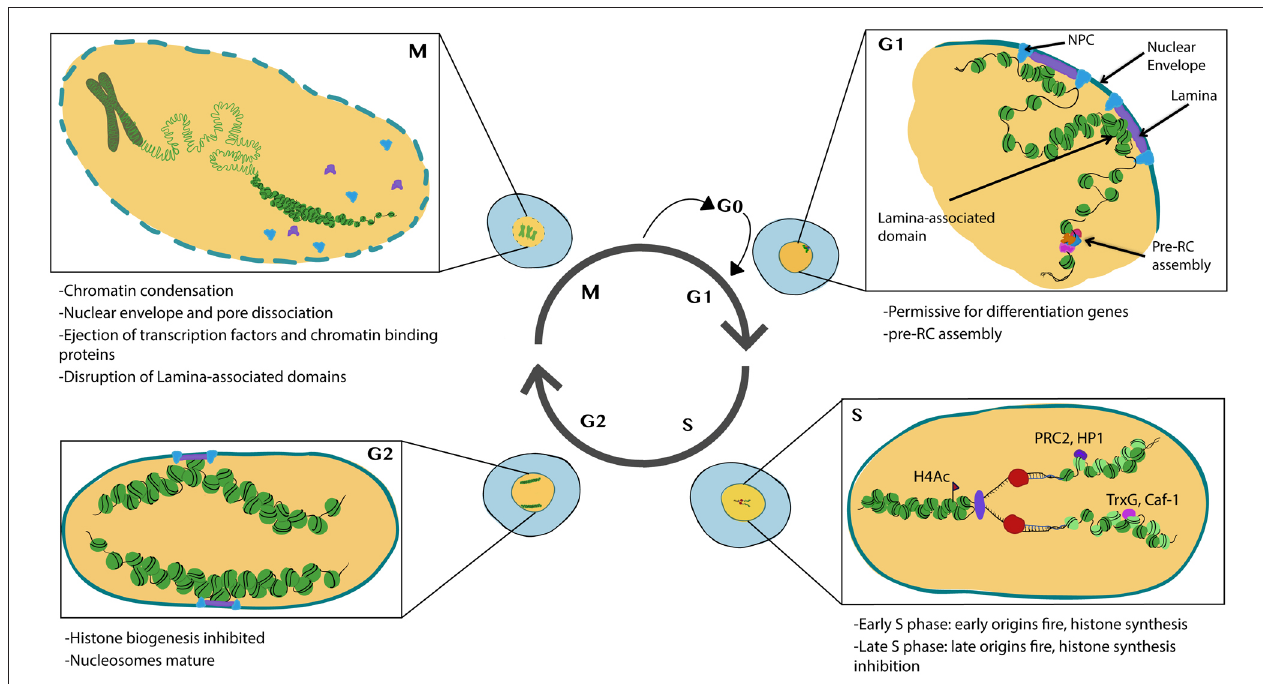
chromatin. PTM writers and readers also associate with nascent chromatin. During G2 nucleosomes mature and histone biogenesis is inhibited. During mitosis, chromosomes condense and many transcription factors and chromatin binding proteins are ejected from the chromatin. The nuclear envelope breaks down disrupting nuclear lamina associated domains. Illustration by Nicole